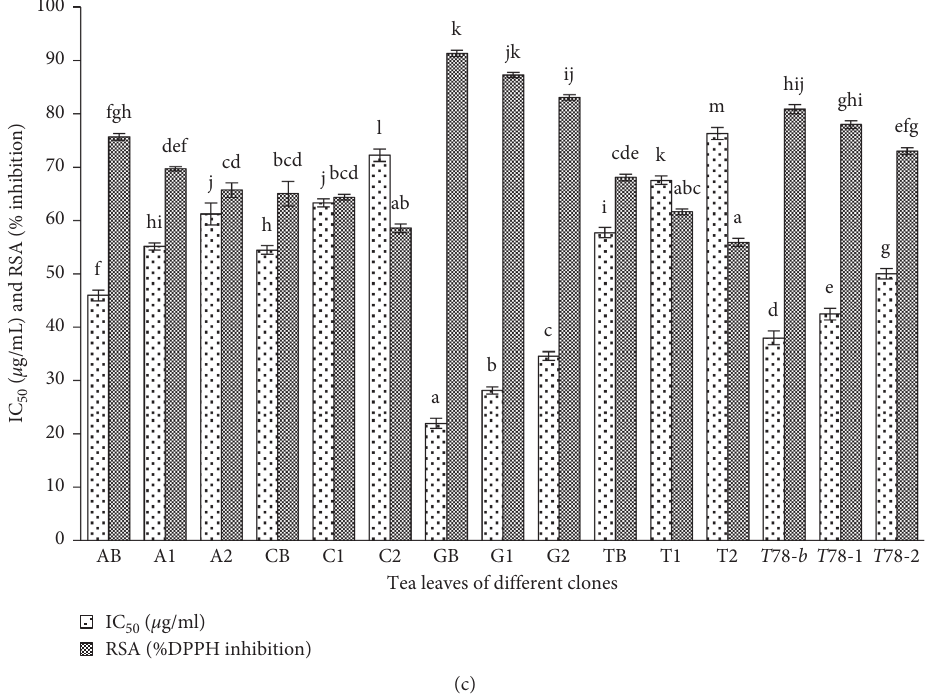
Figure 2: Chemical characteristics of various clones of tea plant at different stages of leaf position: (a) tannin content, total phenol content, and total flavonoid content, (b) caffeine content, and (c) IC 50 and RSA (% DPPH inhibition). Error bars show standard deviation, and error bars bearing different superscripts are different ( p < 0 . 05) with one-way ANOVA, and QE, GAE, RSA refer to quercetin equivalent, gallic acid equivalent, and radicle scavenging activity,